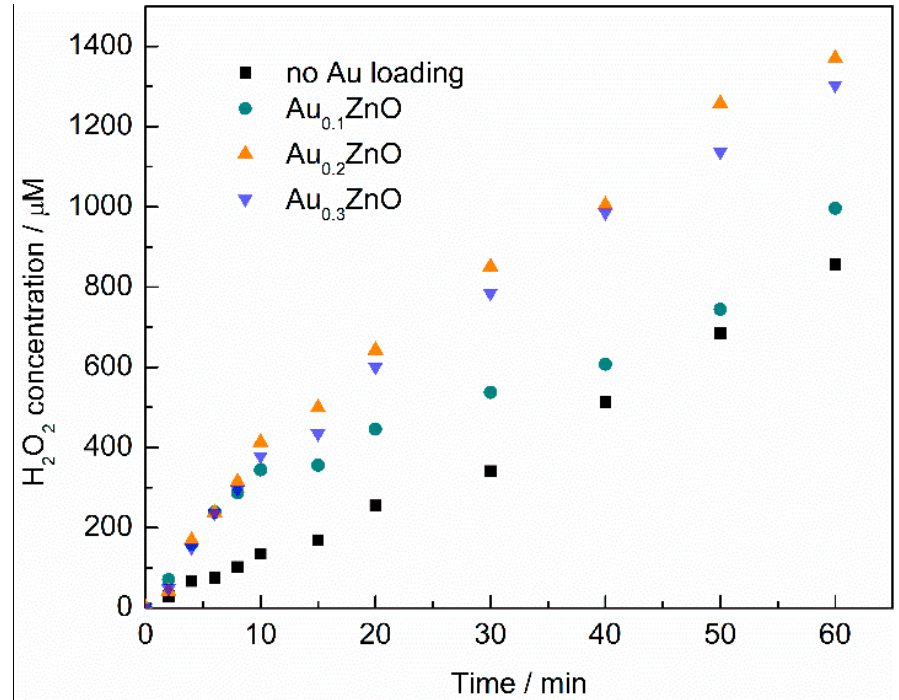
Figure 5. Time-concentration profile of H 2 O 2 generation on different Au-ZnO.